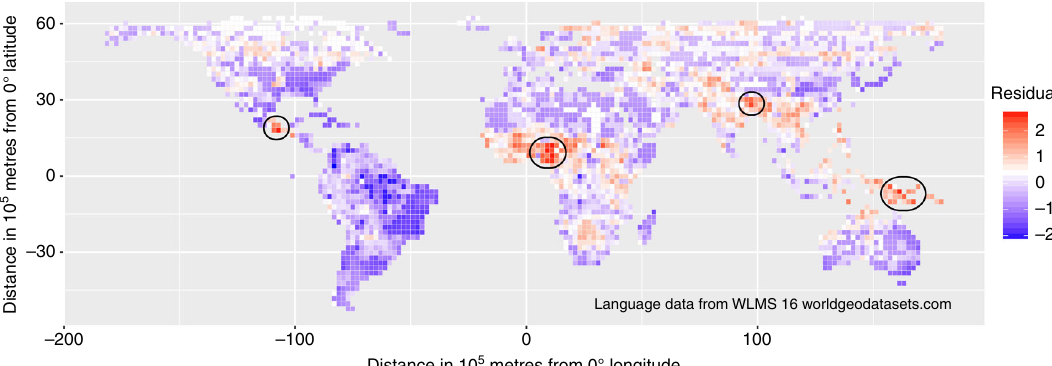
Fig. 3 Global distribution of residuals in language diversity. Residuals after accounting for the climatic and landscape effects on language diversity are shown for 200 × 200 km grid cells of an equal-area grid. Aggregations of grid cells with residuals ≥ 1.96 (red) are circled. These indicate four regions of higher than expected language diversity, compared with regions of similar climate and landscape (New Guinea, Eastern Himalaya, West Africa, and Mesoamerica). Areas of lower than expected language diversity with residuals ≤ − 1.96 (blue) are distributed in South America, mostly in the Amazon basin. The fi gure only shows grid cells for which we have relevant data